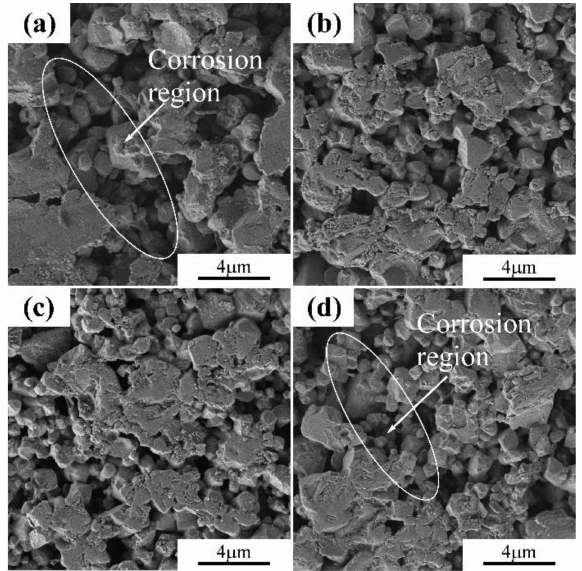
Figure 12. SEM images of the corrosion surface of the (Ti,W)C-xTa-based cermets immersed in